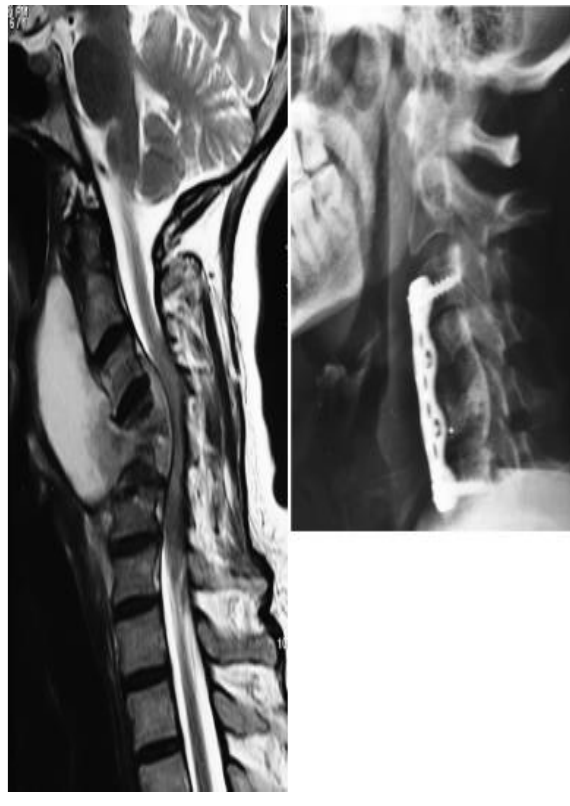
FIG. 1. Preoperative MR image (left) and postoperative radiograph (right) obtained in a patient presenting with spinal TB and severe deficits (Frankel Grade B). Left: Note the C4–5 collapse, epidural and prevertebral collection, severe cord compression, and signal changes in the cord. Right: Note the status of the spine after C4–5 corpectomy and fixation. The patient’s muscle strength improved to Grade 5/5 after